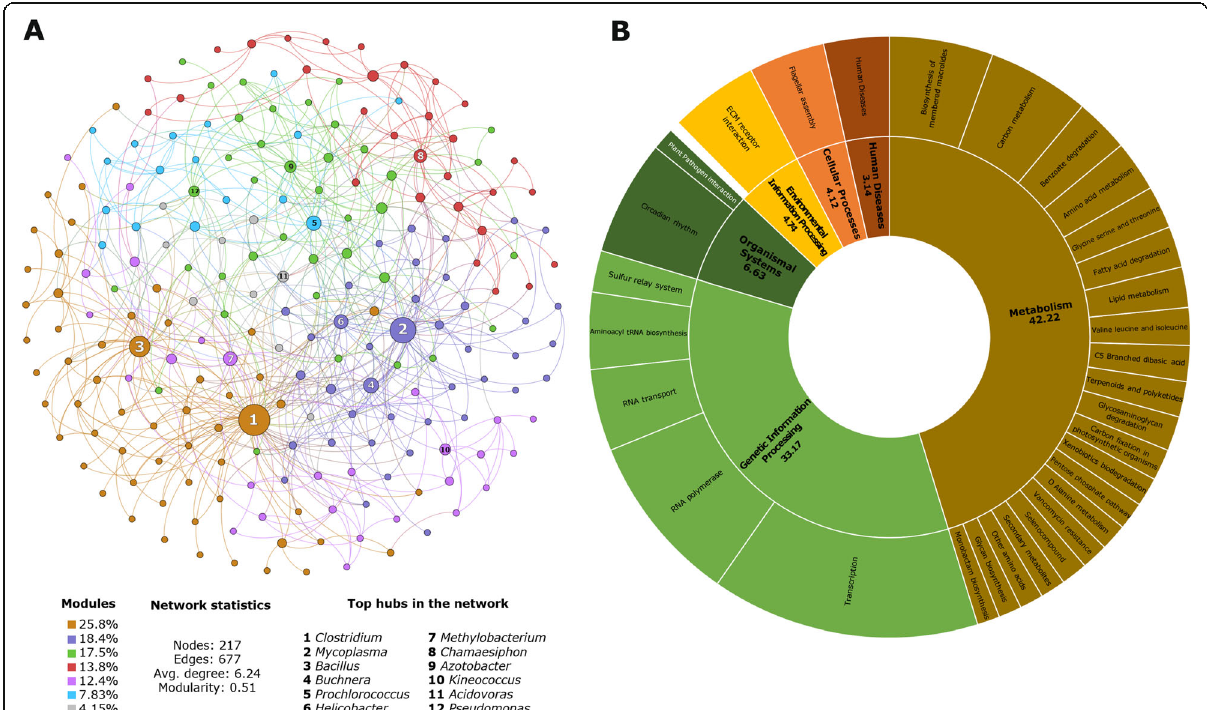
Fig. 2 Structure and functional profile of the rice leaf bacterial communities. a Microbial ecological network from the 3 K microbiome with abundant genera present in at least 50% of all samples. The colors represent the seven modules in the network. Each node represents a genus and the circle size indicates betweenness centrality increment. For the network analysis the genus counts were center-log-transformed. b KEGG pathways entries with more than 1% relative abundance in all rice accessions. The inner circle indicates KEGG class 1 pathways and the external circle indicates classes 2 or